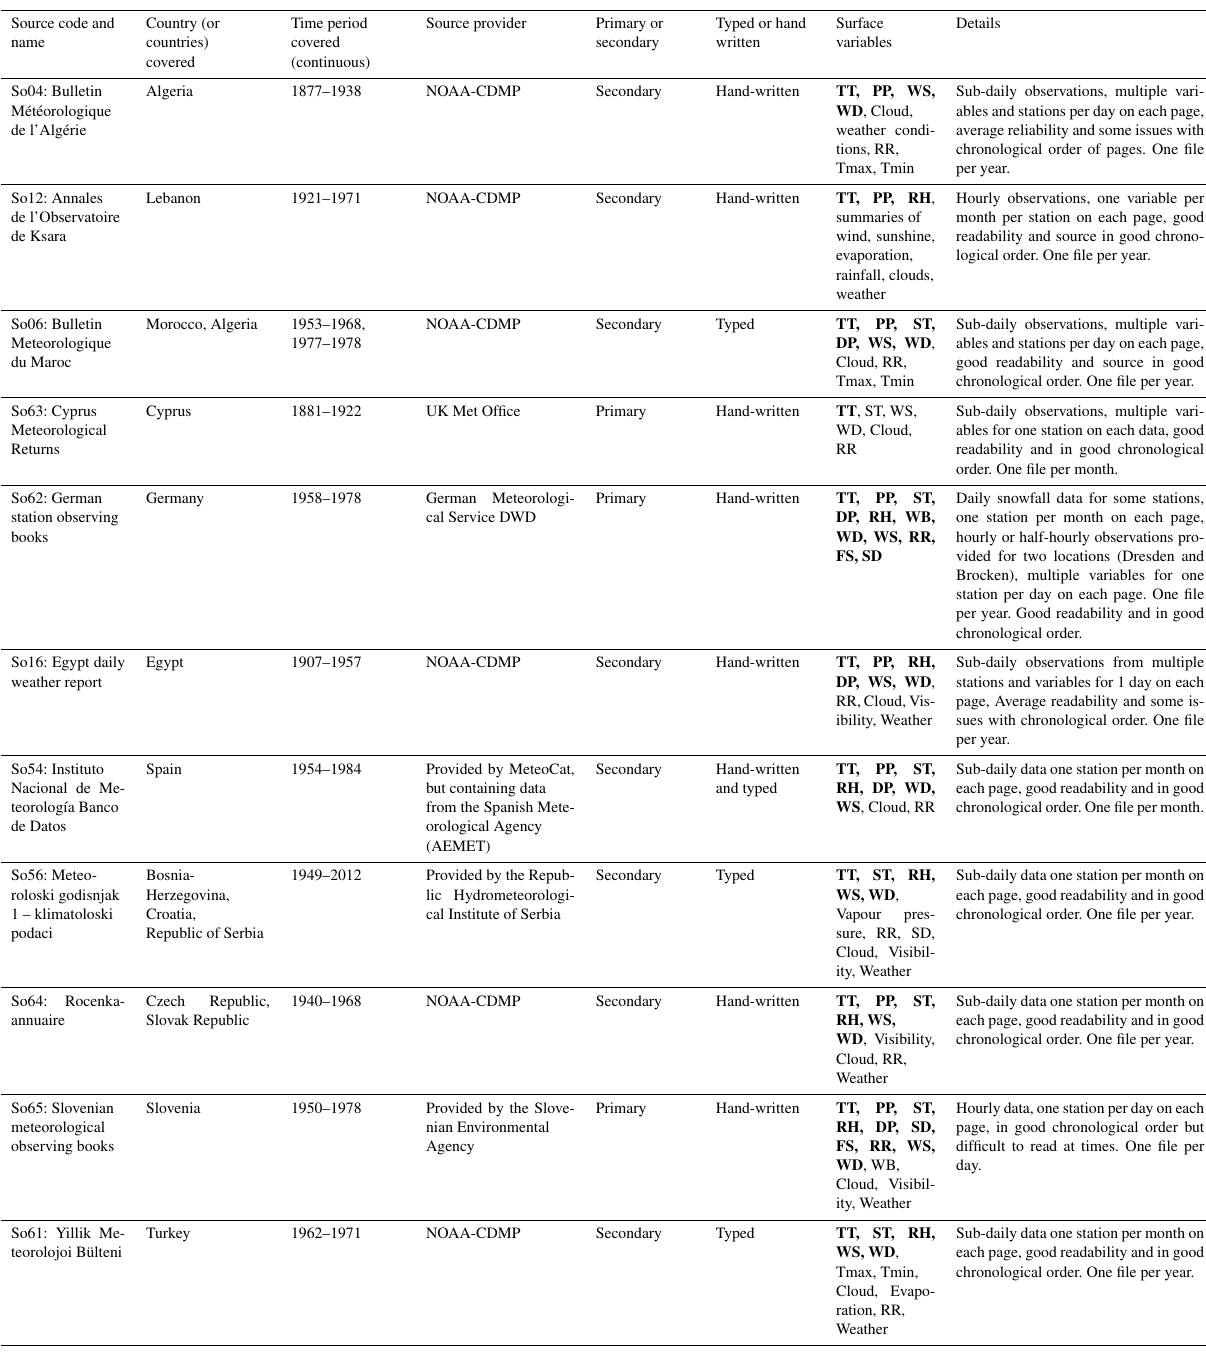
Table 1. An overview of the data sources used in this project. More information on the precise temporal coverage of each location and units are provided with the dataset, available on PANGAEA (Ashcroft et al., 2018). Variables given in bold in the variable column have been digitised as part of this project: not all available variables and time periods were digitised in this project due to time and funding constraints. Each source can be found at ftp://130.206.36.123 (last access: 4 June 2018), u: C3_UERRA, p: c3uerra17, folder: C3_UERRA_datasources_images, where the sources are listed under their source code. In the source location column, NOAA-CDMP repre- sents the National Oceanic and Atmospheric Administration Climate Data Modernisation Project. The variables are represented by acronyms similar to those used in the main text: temperature (TT), relative humidity (RH), dew point temperature (DP), mean sea level pressure (PP), and station level pressure (SP), wind direction (WD), wind speed (WS), wet bulb temperature (WB), precipitation (RR), snow depth (SD) and fresh snow (FS), maximum temperature (Tmax) and minimum temperature